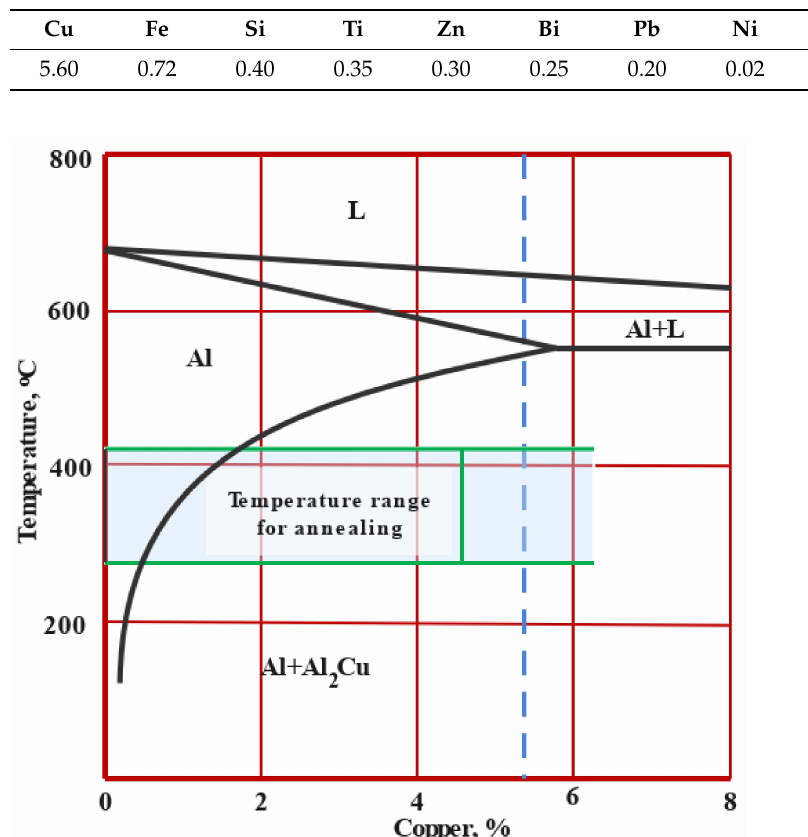
Table 1. Chemical composition of AA2011 aluminum alloy (in wt.%).